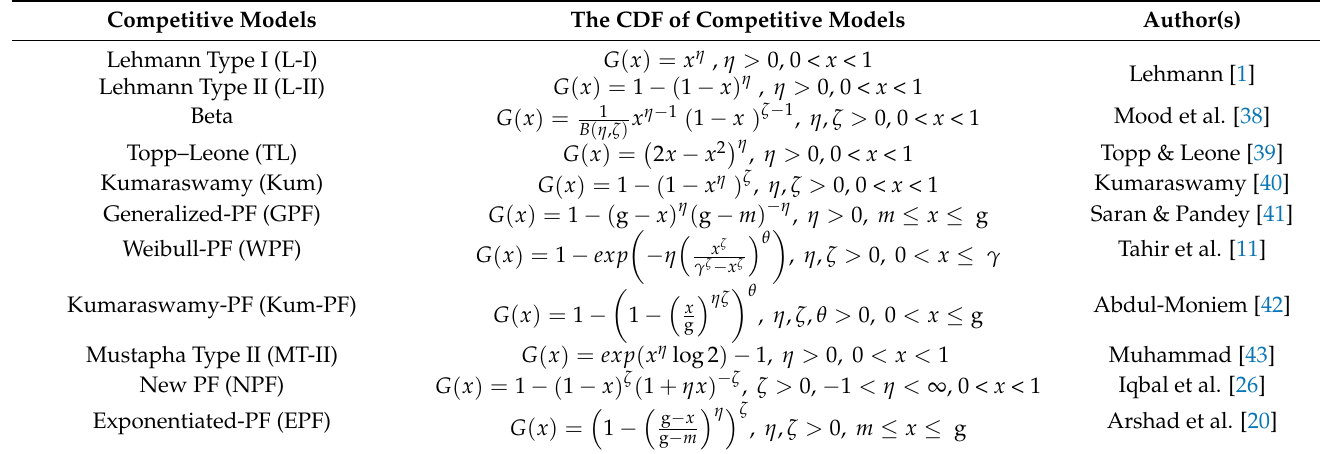
Table 8. List of some competitive models along with their CDFs.